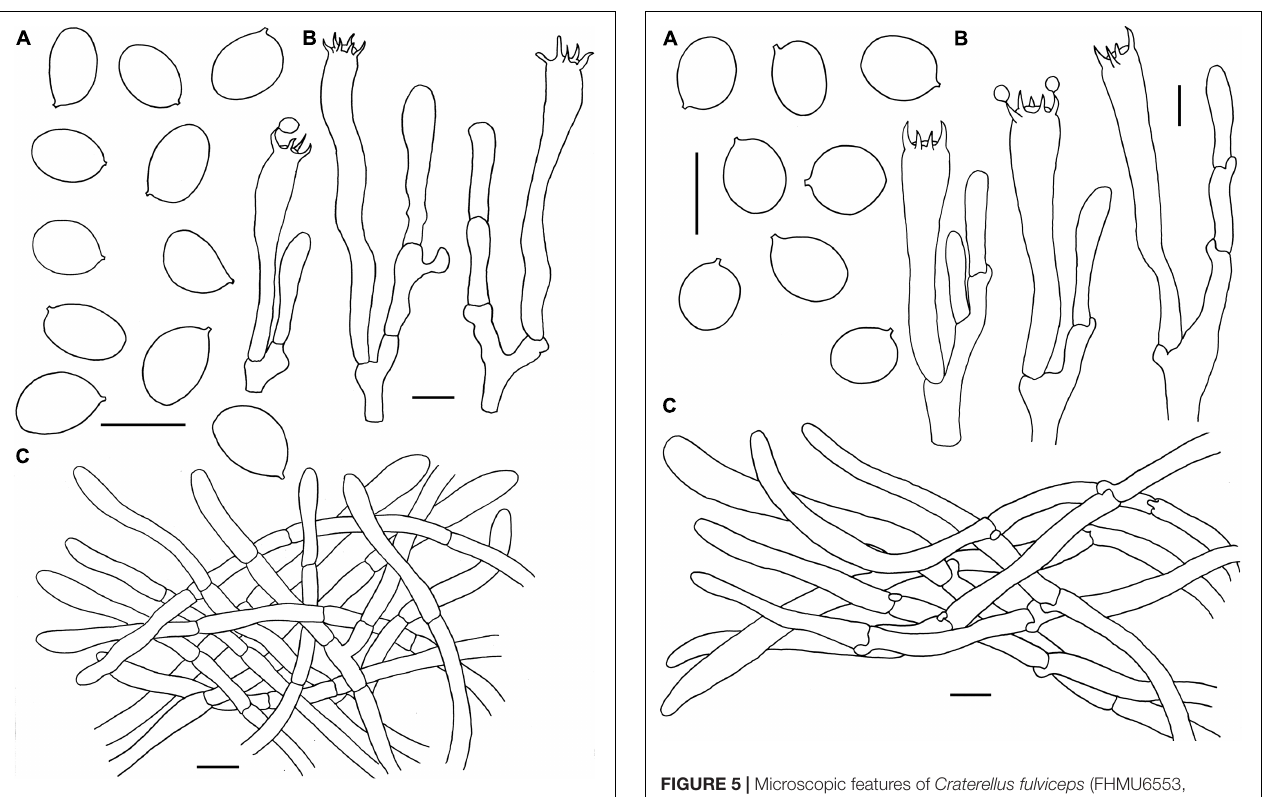
FIGURE 4 | Microscopic features of Craterellus aureus (FHMU2407). (A) Basidiospores. (B) Basidia. (C) Pileipellis. Scale bars = 10 µ m. Drawings by Y.-Z. Zhang.